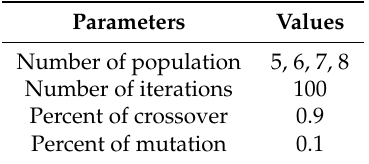
Table 2. Objective function parameters for the annual energy production (AEP). Table 1. NSGA-II parameters for optimization.